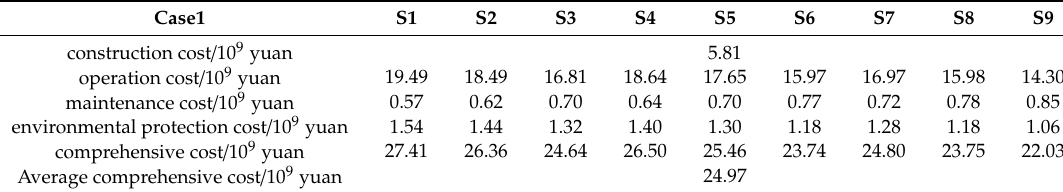
Table 6. Costs under multiple natural gas price fluctuation